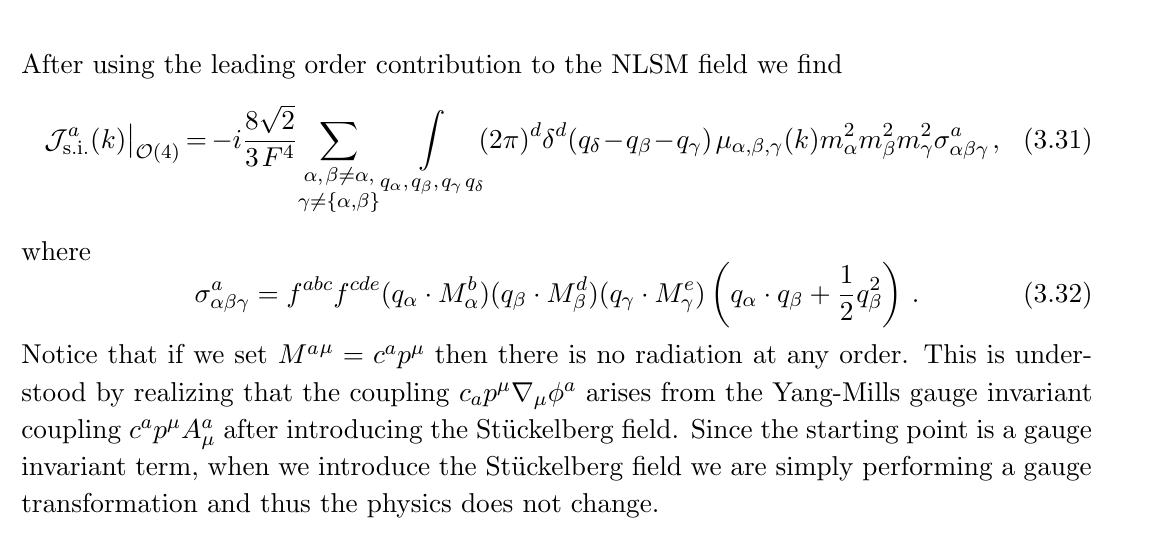
Figure 5 . Interactions contributing to the NLSM source at O (4). The left-hand side shows the contribution from the interactions between the point-particles and pions and the right-hand side shows the contribution from the pion 4-point